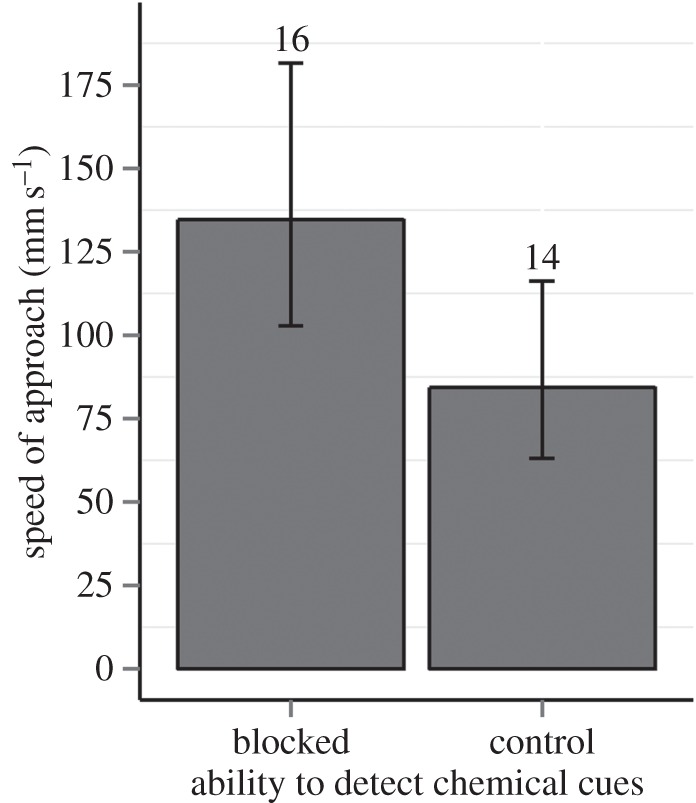
Speed of approach by intruder Neogonodactylus oerstedii towards a resident's refuge (mean, 95% CI) at the beginning of a fight. The intruder's ability to detect chemical cues was removed by dipping antennae in freshwater. Numbers indicate sample size.